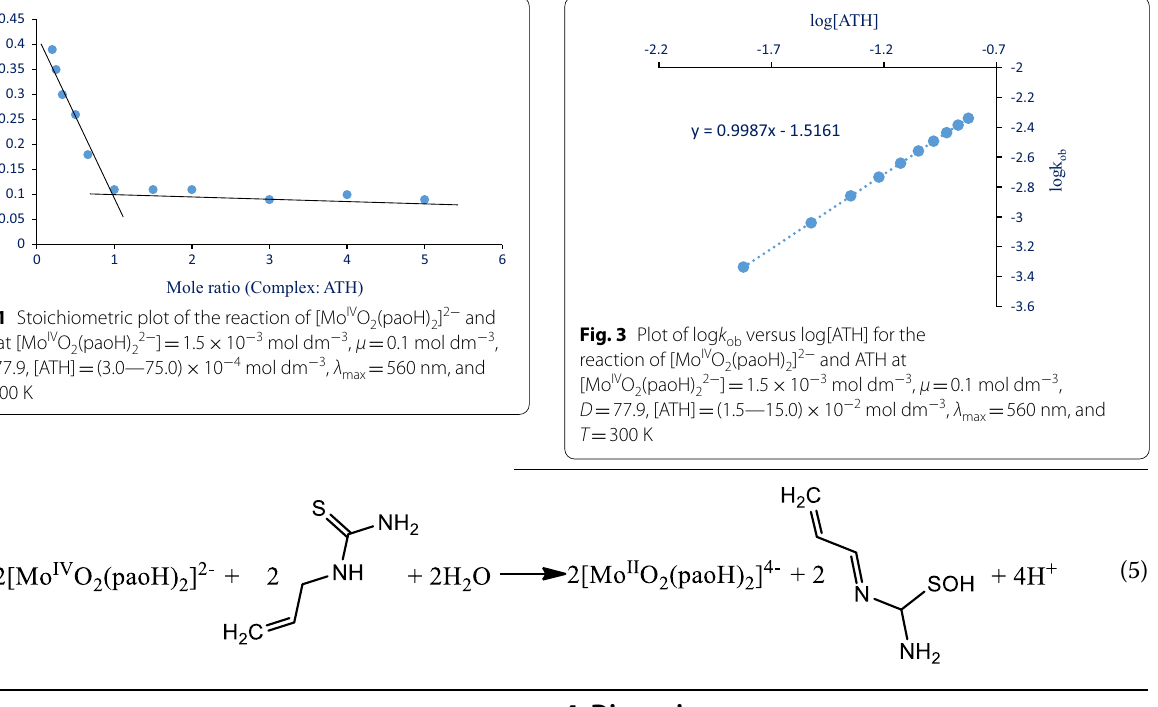
The pseudo-first-order plot and the logarithmic plot of the observed rate constant with the concentration of the reducing agent which reveals the order of the sub- strate concentrations in the reaction are presented in Figs. 2 and 3, respectively. The observed rate and second rate constants for the kinetic measurement are shown in Table 1. The medium polarity and the counter-ion effects on the reaction rate are displayed in Tables 2 and 3, and Pisz- kiewicz’s and Berezin’s parameters which explain the micellar effect of the surfactants on the reaction rate are presented in Table 4.